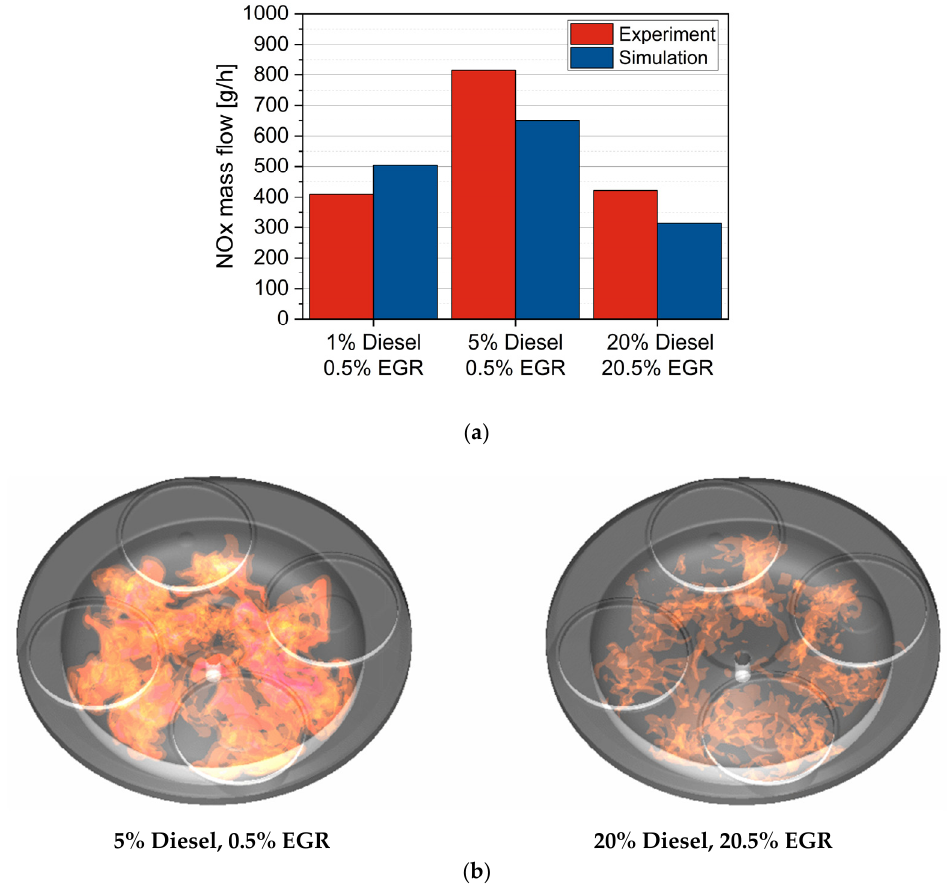
Figure 7. ( a ) Comparison of simulated and measured NO x emissions for a large dual fuel engine with different diesel substitution and EGR rates; ( b ) nitric oxide iso-surfaces at 10° CA after TDC.